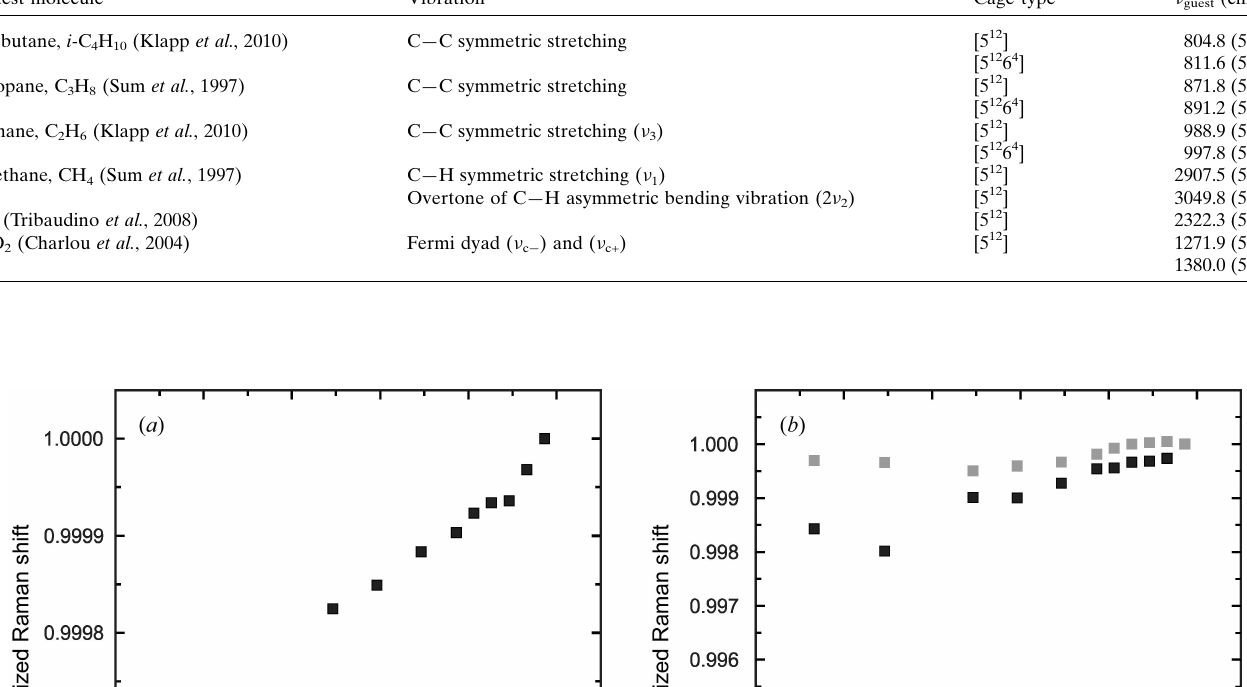
Table 2 Individual Raman vibrations of the guest molecules and their assignment to the two types of framework cages at T = 293 K. Guest molecule Vibration Cage type (cid:8) guest (cm (cid:4) 1 ) Isobutane, i -C 4 H 10 (Klapp et al. ,